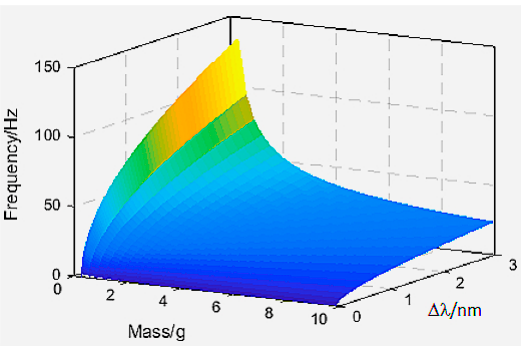
Figure 4. The relationship between frequency ω y and mass and center wavelength shift of fiber grating under prestrain.